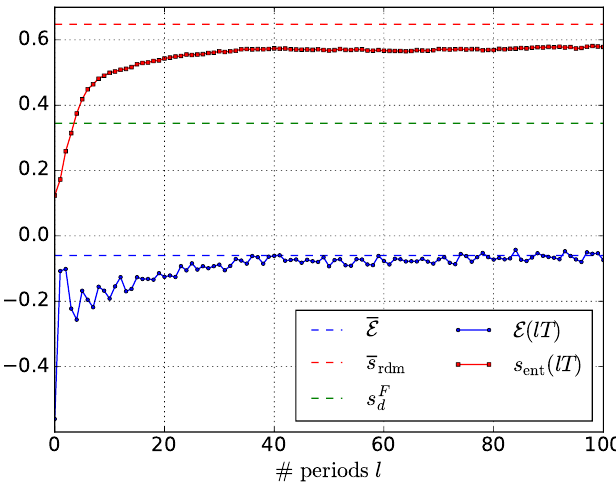
Figure 2: Stroboscopic dynamics of the energy density and entanglement entropy density (solid lines), together with their infinite-time values (dashed lines) in the periodically-driven TFIM in a parallel field. The parameters are g / J = 0.809, h / J = 0.9045, Ω / J = 4.5, and L =